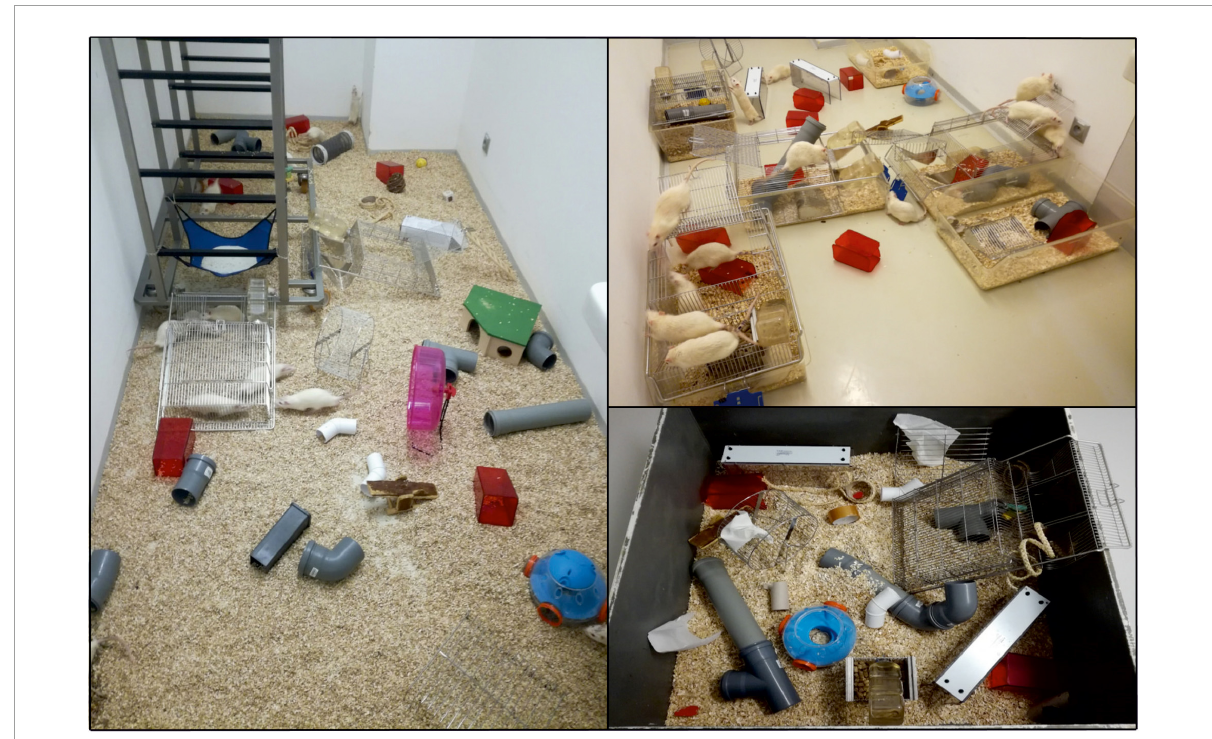
FIGURE1 Illustration of enriched environment in laboratory conditions. Animals are introduced to novel objects, social housing, and exercise opportunities to maximize their exploration and exercise. Objects include running wheels, shelters, paper rolls, toys or different types of material to gnaw on, which typically vary in color, size or